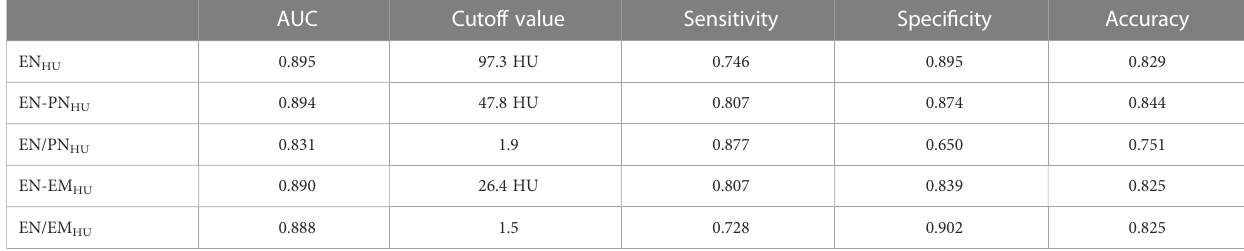
TABLE 3 Diagnostic ef fi cacy of EN HU , EN-PN HU , EN/PN HU , EN-EM HU , and EN/EM HU for LN metastasis in PTC.